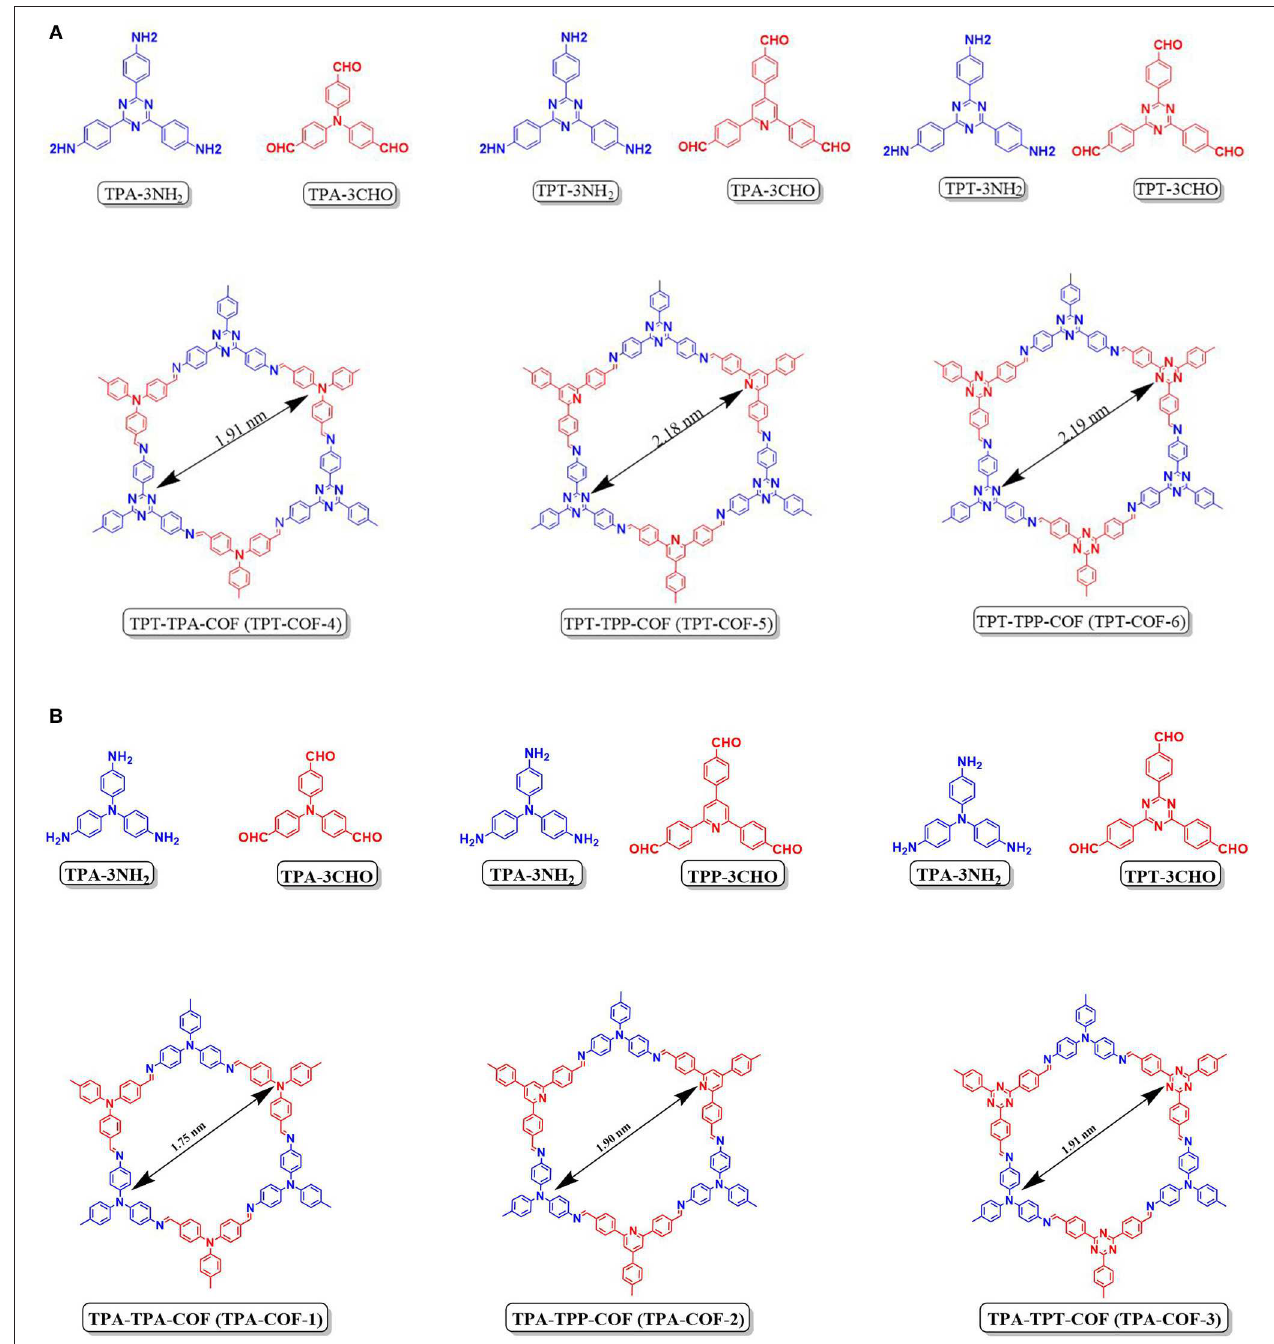
FIGURE 5 | (A,B) Building blocks and structure of TPA and TPT COFs as reported by EL-Mahdy et al. (2018) Reprinted with permission © 2018 Royal Society of Chemistry. the symmetry and planarity are the two main factors that affect the COF’s total surface area. Synthesizing COFs with less planar starting materials reduced the surface area for both the symmetric and unsymmetrical